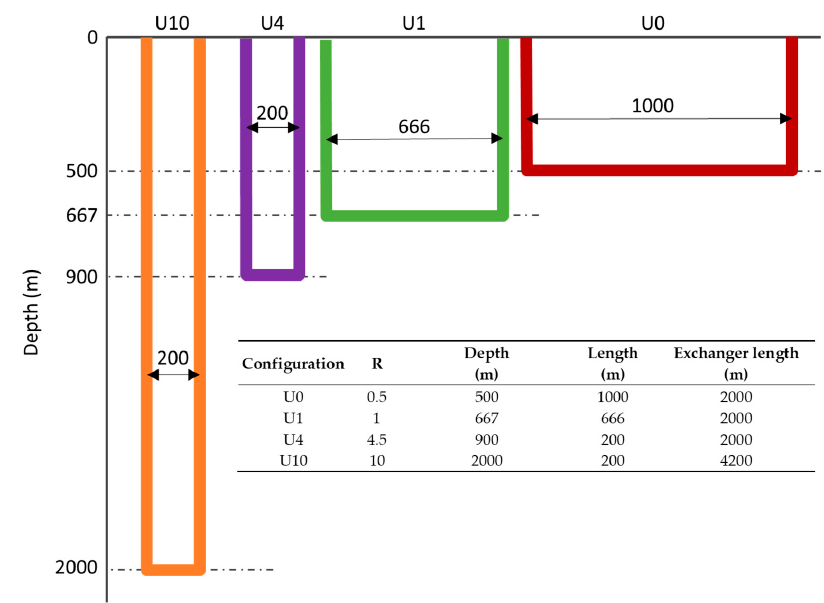
Figure 4. ULHE geometry configurations.